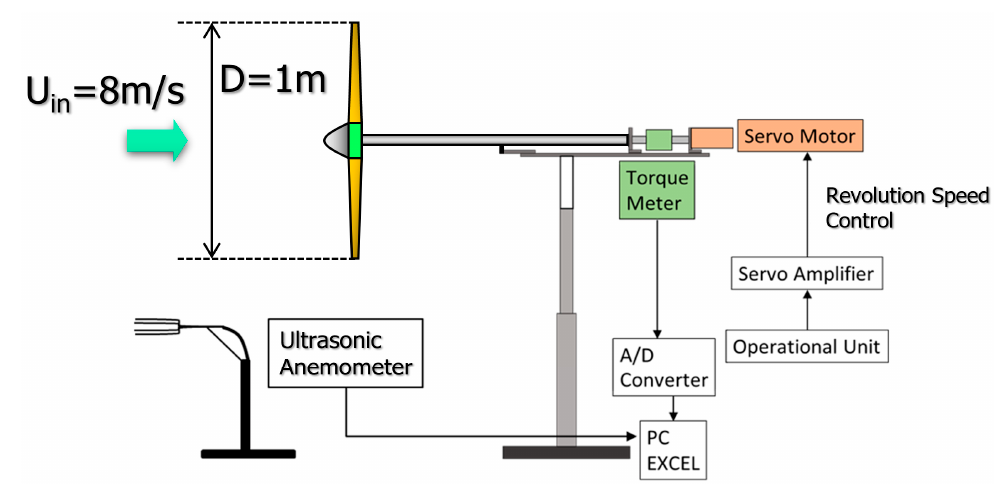
Figure 4. Schematic view of the torque-measurement system used in the performance test of the wind-turbine model manufactured in this study.